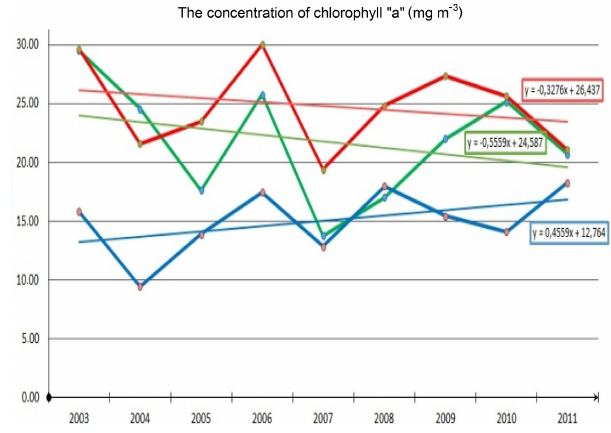
Figure 6. Averaged CHL concentrations in the Ob Bay (green – river, red – middle, blue – sea parts).